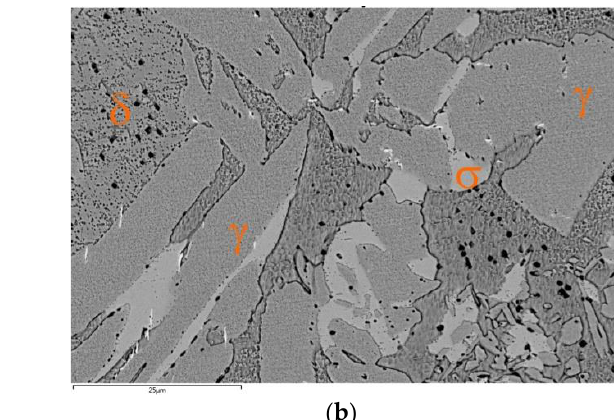
Figure 7. Diffractogram of tested cast steel after holding at 750 °C for 1 and 3 h: ( a ) traditional etching; ( b ) deep etching (T in denotations).